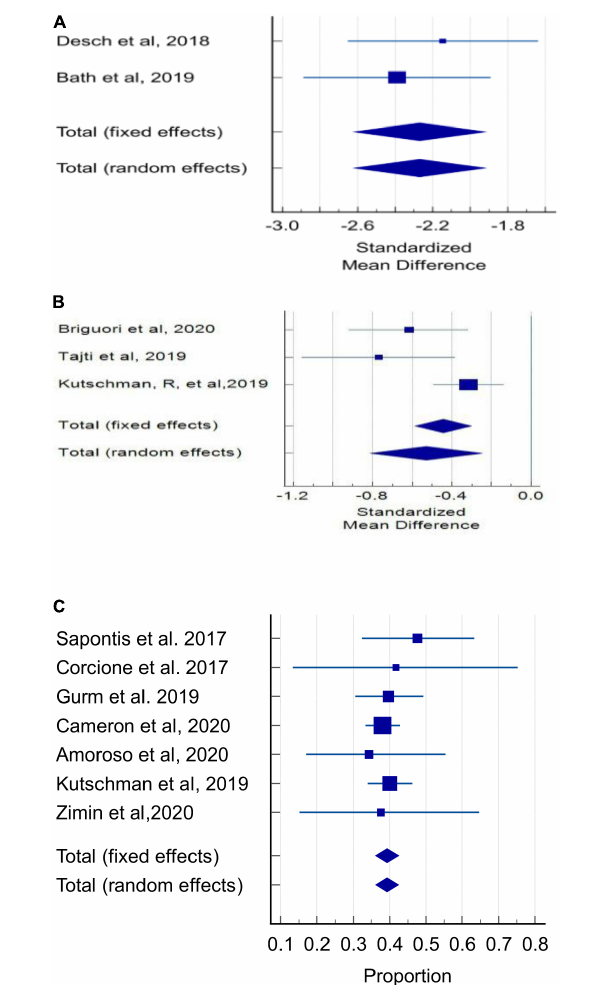
FIGURE 2 | Contrast media volume use. (A) Forest plot of mean difference in absolute contrast volume (mL) in randomized controlled trials. (B) Forest plot of mean difference in absolute contrast volume (mL) in observational studies. (C) Forest plot of proportion of attempted CMV that was diverted (%) in observational studies.